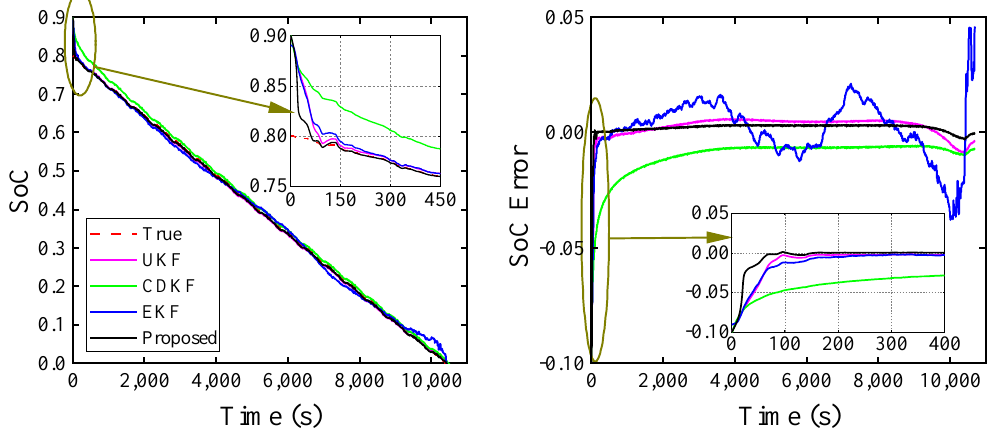
Figure 12. The initial SoC guess was 0.9 under the US06 condition. We used five evaluation indicators of RMS Error-MAE SI MAPE and VAF to further compare the SoC estimation effects of the four algorithms. The error comparison chart is shown in Figures 13–16 where the root mean square error (RMS), average absolute error (Error-MAE), scattering index (SI), average absolute error percentage (MAPE) and vari- ance (VAF) of the SoC is shown. The error results have been combined in Table 6. The time of initial error convergence is shown in Table 7.